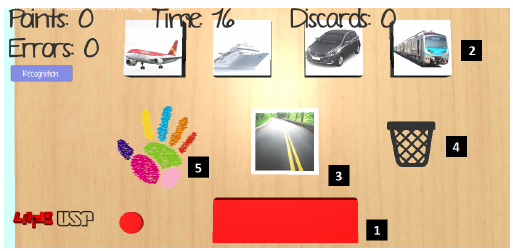
Figure 1: Main interface of the AGaR: Area 2 represents the se- lectable images, Area 3 represents the target image and Area 4 rep- resents the discard